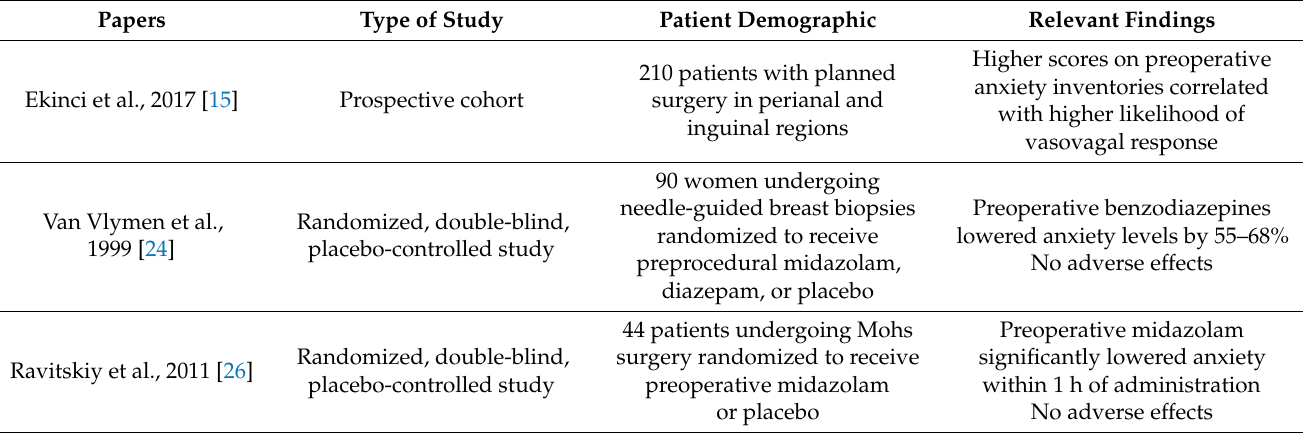
Table 4. Anxiety and anxiolytic use in vasovagal